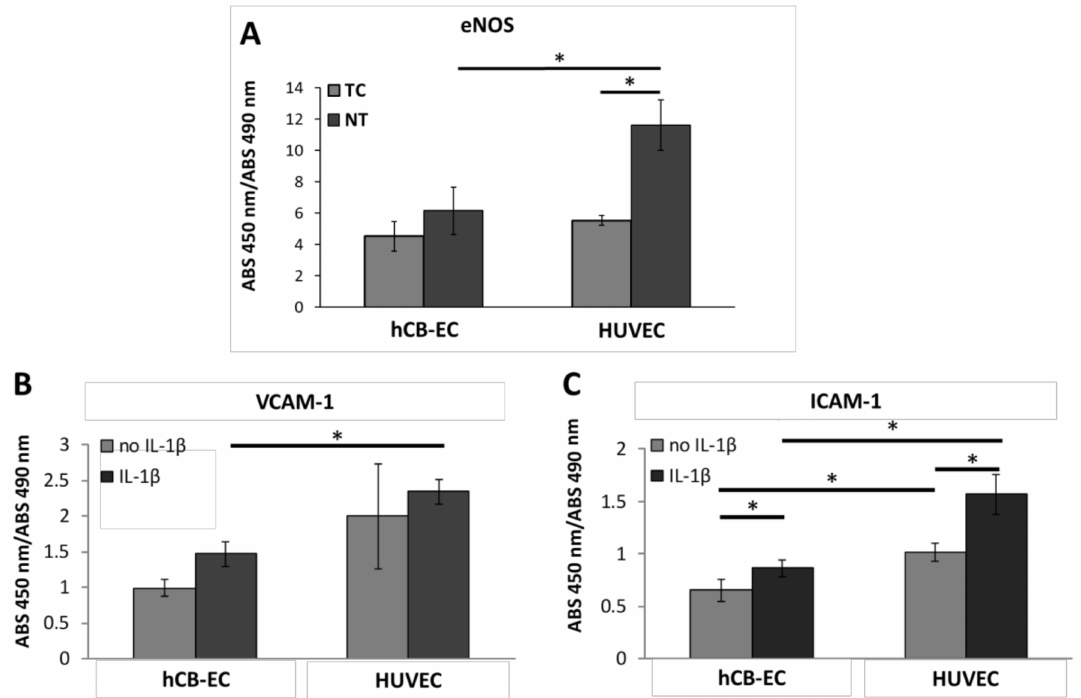
Figure 7. Endothelial nitric oxide synthase (eNOS) production and response to IL-1 β of hCB-EC- and HUVEC-seeded scaffolds. ( A ) eNOS ELISA was quantified and normalized to MTS assay. The eNOS production is significantly lower in hCB-ECs as compared to HUVECs when seeded on NT scaffolds (* p < 0.05; n = 4). ( B ) Anti-vascular cell adhesion molecule 1 (VCAM-1) ELISA in TC scaffolds with or without the addition of 0.5 ng/mL of IL-1 β show that HUVECs have higher response compared to hCB-ECs (* p < 0.05; n = 4). ( C ) ELISA of anti-intercellular adhesion molecule 1 (ICAM-1) shows that HUVECs have higher response compared to hCB-ECs (* p < 0.05; n =